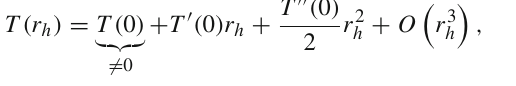
Fig. 3 The evolution of the massive gravity black hole event horizon radiusasfunctionoftime.Herewechoose r h ( 0 ) = 1000.Theblackhole parameters are m = k = c = 1, c 2 = − 1. The black hole asymptotes to zero size as time goes to infinity